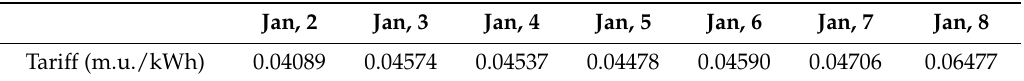
Table 11. Price value for each study